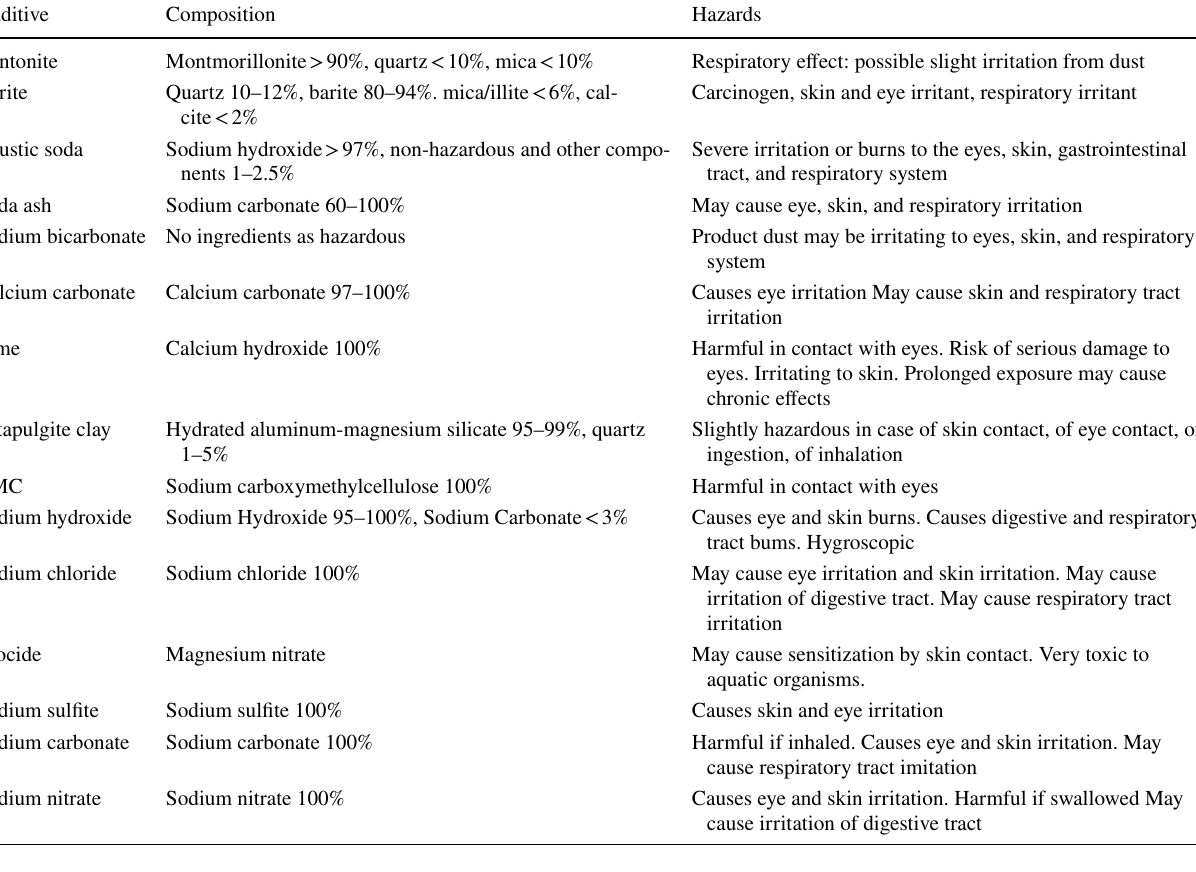
Table 1 Some of the conventional toxic additives for the drilling fluids (Basra Oil Company 2017; Halliburton 2018; Baker Hughes 2010; New- park Drilling Fluids 2012; Al-Hameedi et al. 2019a)